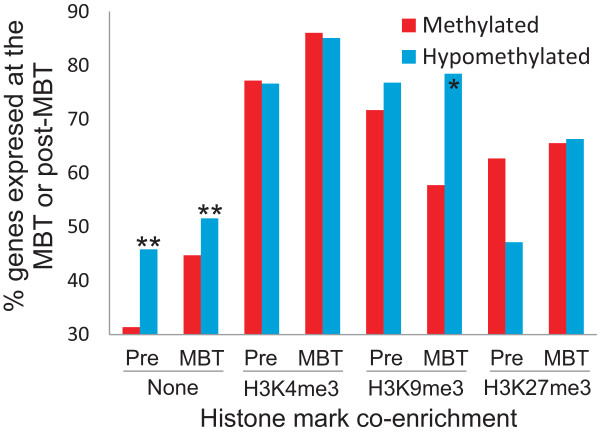
Promoter marking by modified histones before ZGA onset is associated with enhanced gene expression potential after ZGA. Graph shows the percentage of expressed genes (≥5 RNA-seq reads) at or after the MBT (post-ZGA) as a function of promoter DNA methylation state and marking by H3K4me3, H4K9me3 or H3K27me3 at the pre-MBT or MBT stages. **P < 10-5; *P < 0.001; -P = 0.058 (Chi-square test with Yate's correction).